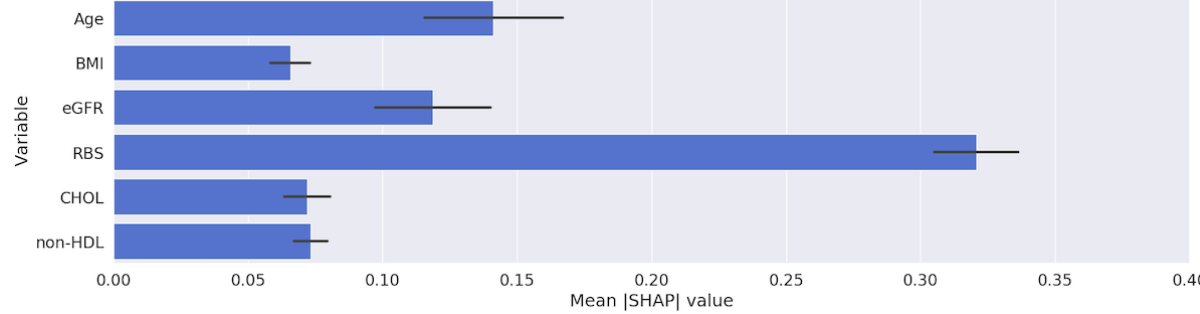
Figure 9. An example showing the SHAP values for randomly selected sample with normal glycated hemoglobin levels (<5.7%). CHOL: total cholesterol; eGFR: estimated glomerular filtration rate; non-HDL: non–high-density lipoprotein; RBS: random blood sugar; SHAP: Shapley Additive Explanations.